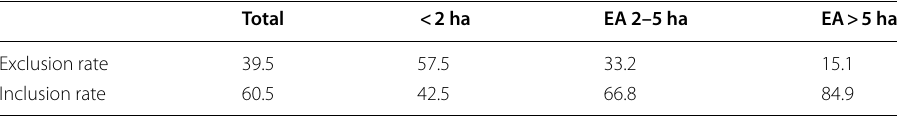
Source : INE Agricultural Census